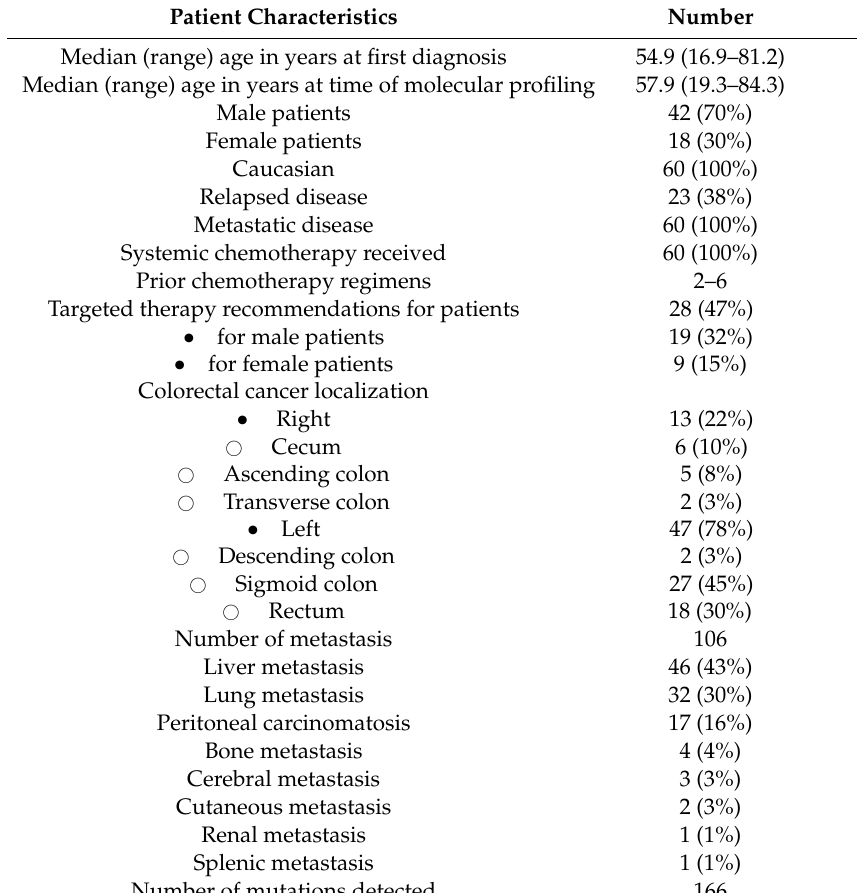
Table 1. Patient characteristics ( n =